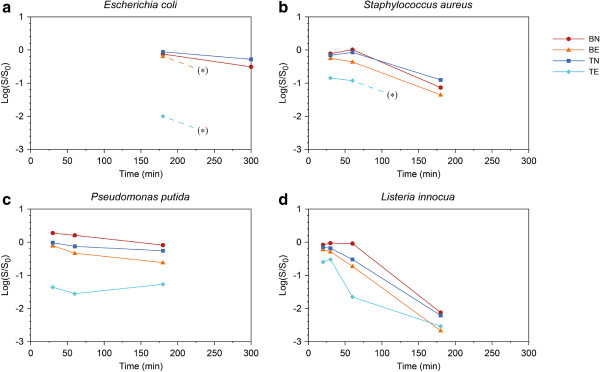
Antibacterial activity of P25-coated Petri dishes on different bacterial species. (a)E. coli(b)S. aureus(c)P. putida(d)L. innocua. Dashed line and (*) indicates an unavailable trend estimation because of the zero survival of the next-step sample.